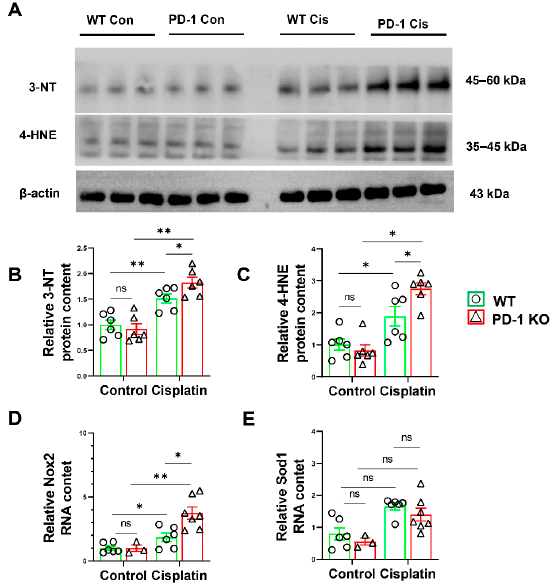
the mice after cisplatin treatment.